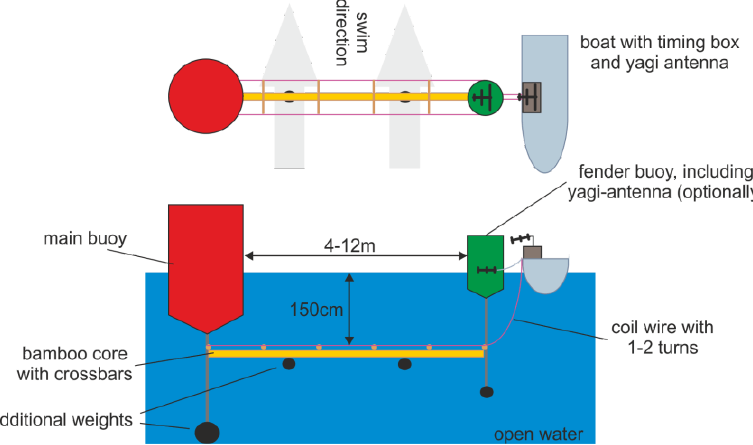
Figure 4. The bamboo core as part of the completely timing system device with the view from top and along the swimmers direction. The core has a sufficient depth to permit the passing of boats between the buoys. All the electronic components are inside the timer’s boat, when using the MTS J-Chip system, a separate Yagi-antenna is